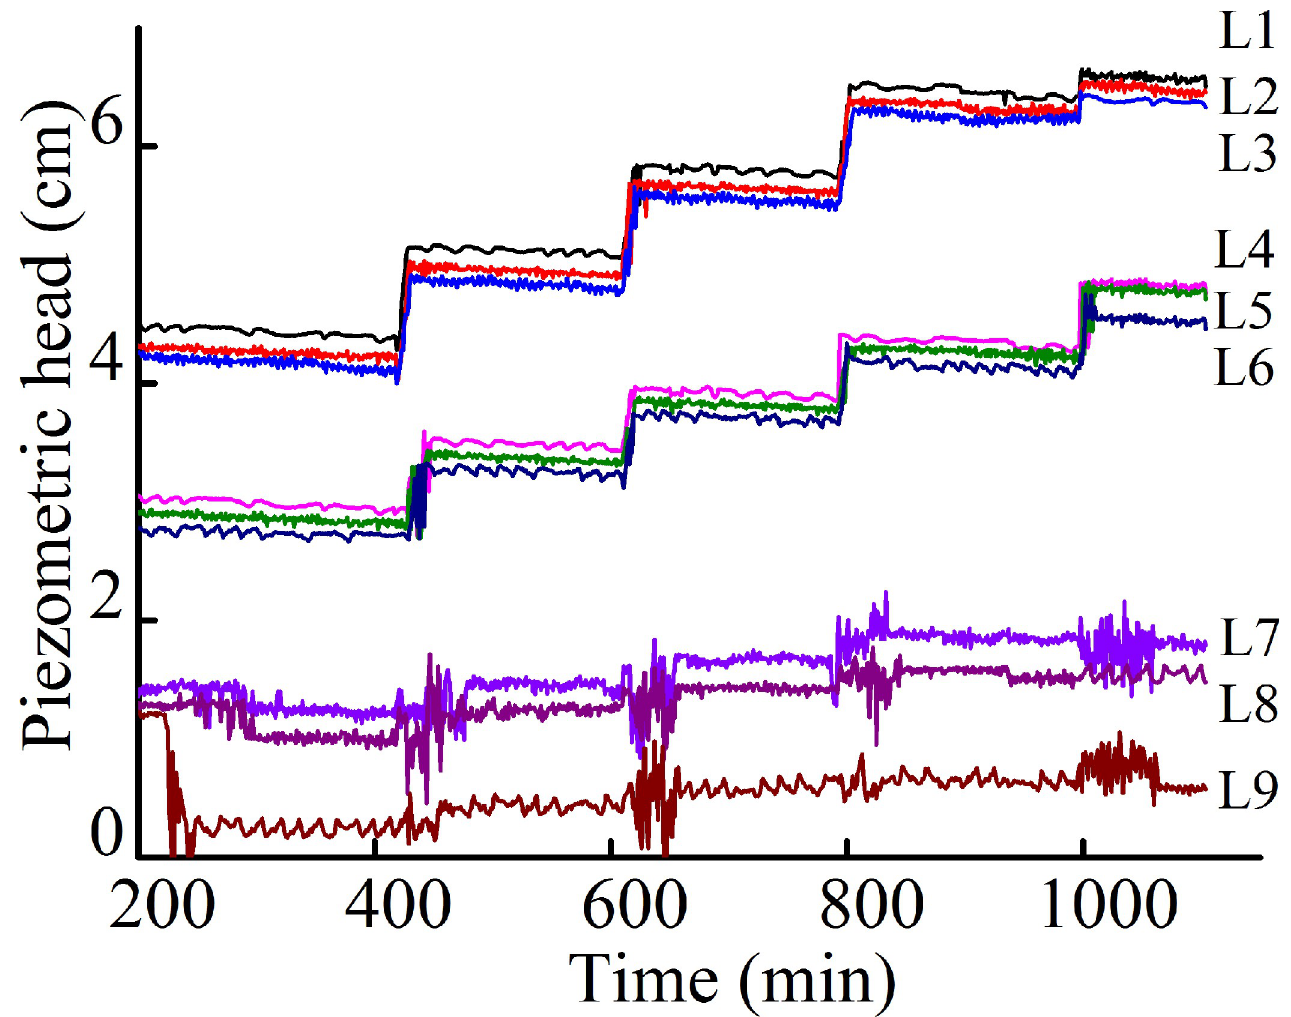
Fig 4. Variation in piezometric head during Soil A